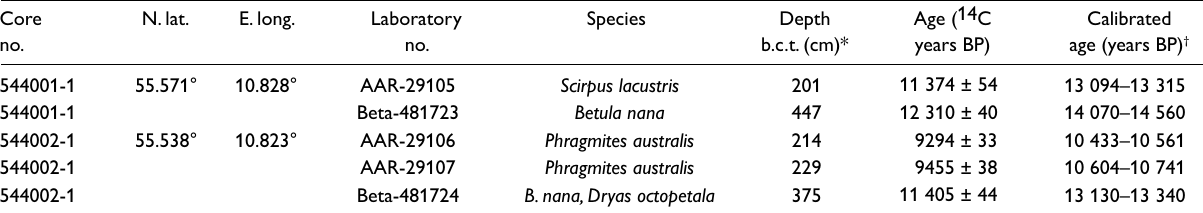
Table 1. New radiocarbon ages from Storebælt, Denmark